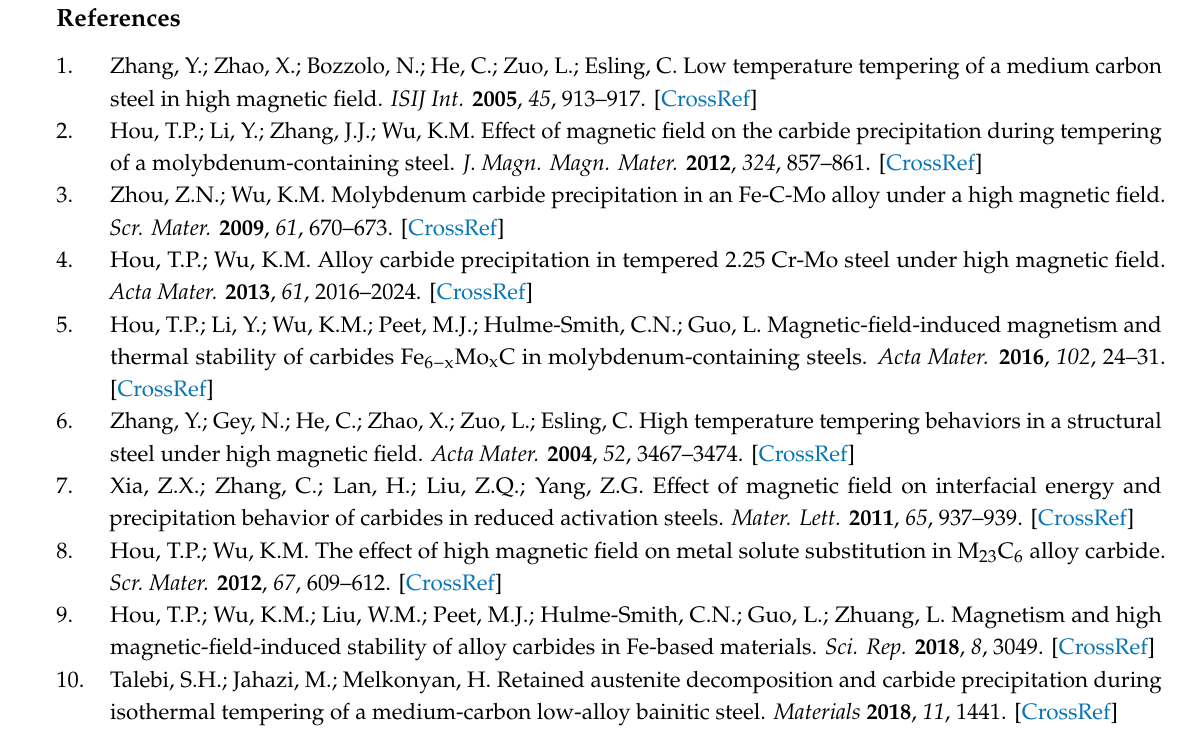
Table S1: Parameters of C, Cr and Fe in the atomic scattering factor analytical